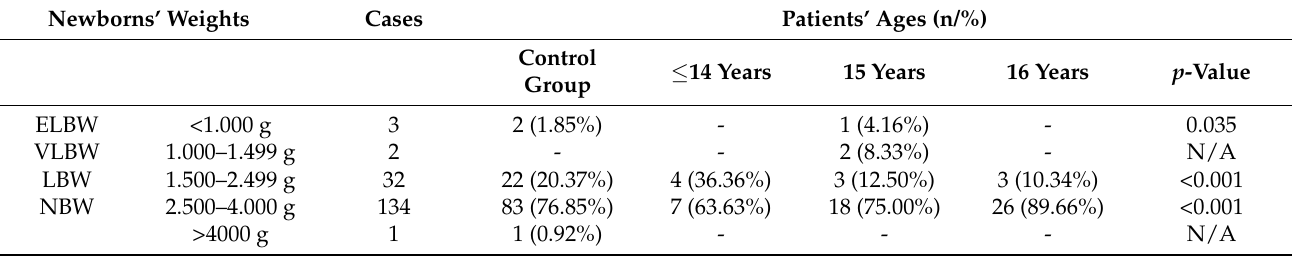
Table 8. Newborns’ distribution in relation to their weights and maternal